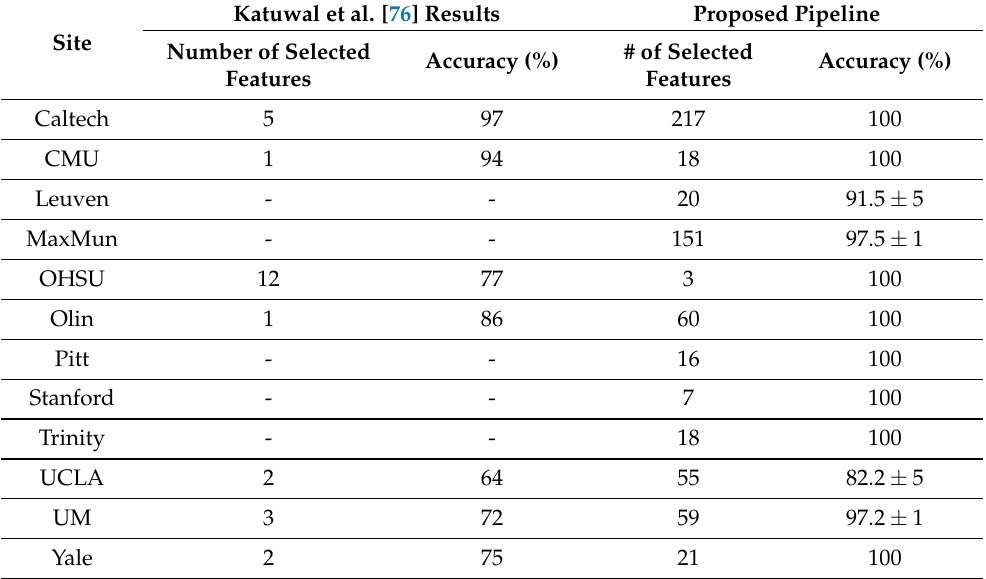
Table 2. Comparison between the proposed pipeline and previous results from the literature.